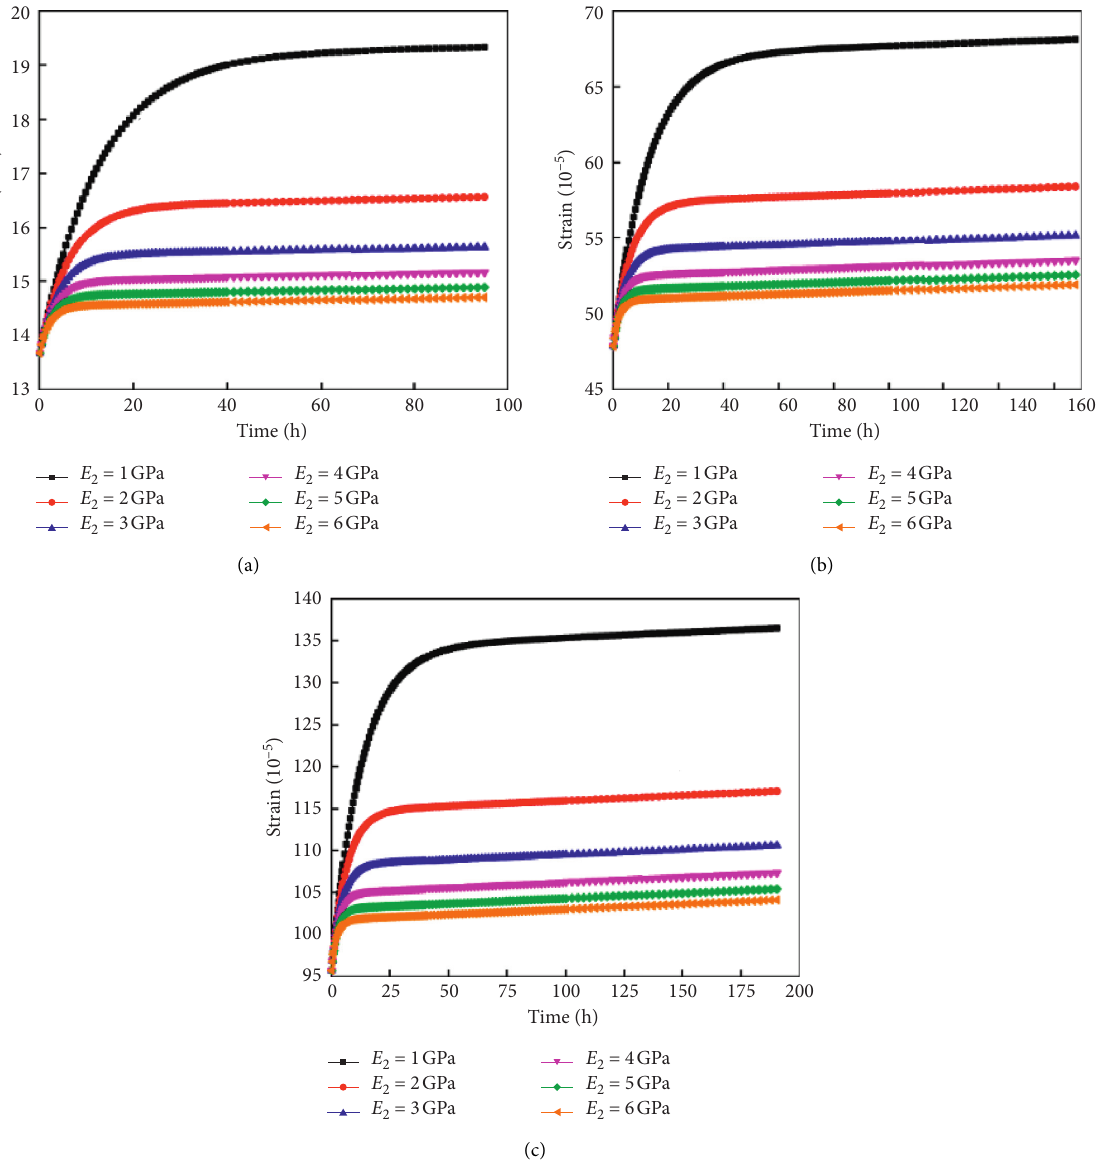
Figure 22: Effect of E 2 on the strain of tunnel anchor under loads of (a) 1.0 N m , (b) 3.5 N m , and (c) 7.0 N m